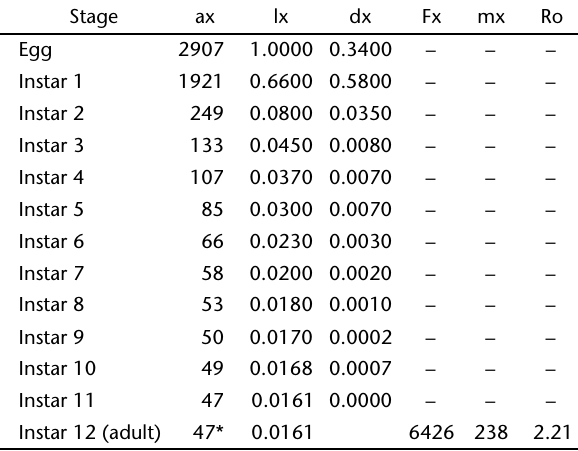
Table II. Life table for the Aglaoctenus lagotis spider under captive conditions. The letters indicate: (ax) number of individuals present in each instar, (lx) proportion of individuals surviving at each time interval, (dx) mortality rate, (Fx) total number of eggs produced by the females when reaching maturity, (mx) individual fecundity, (Ro) basic reproductive rate, (X) number of the instar (Egg = instar